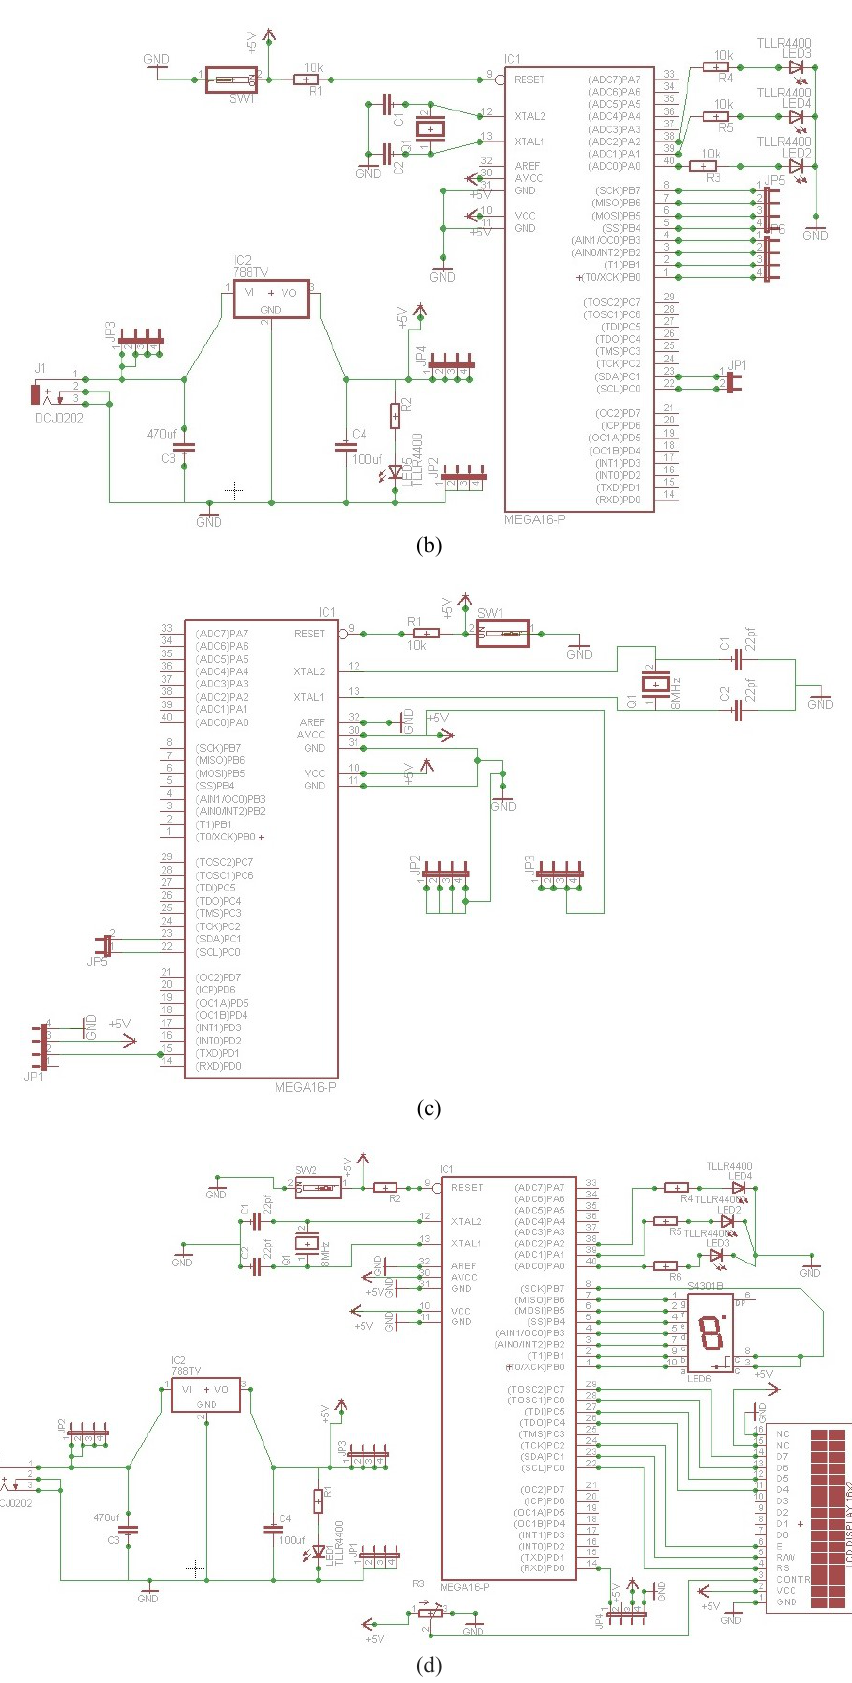
Fig.3 (a) Proteus simulation (b) RSU board (imitation as done to verify our purpose only) (c) ZigBee sender board (d) ZigBee receiver board with LCD screen